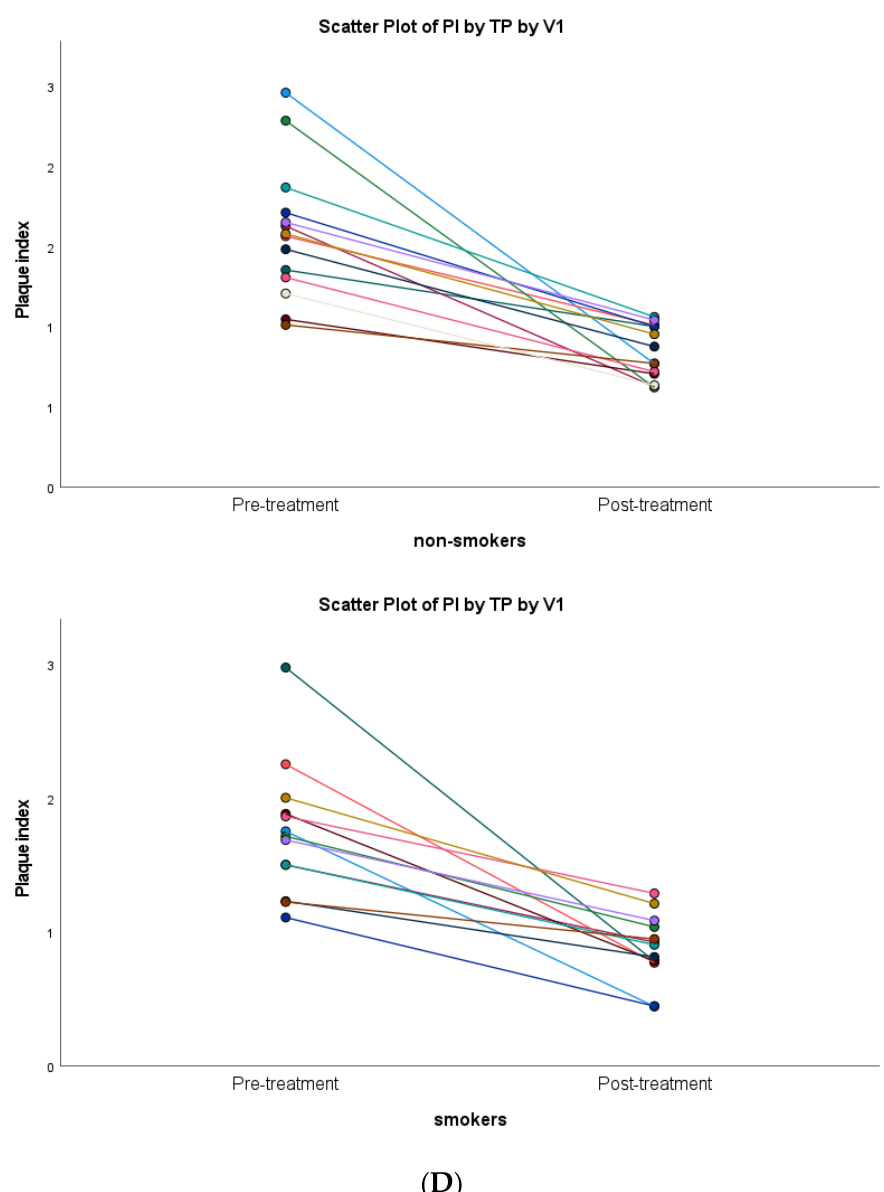
Figure 3. Scatter plots of the association of anti-infective periodontal treatment with smoking versus non-smoking subjects: ( A ) PD = probing depth; ( B ) BOP = bleeding on probing; ( C ) CAL = clinical attachment level; ( D ) PI = plaque index.